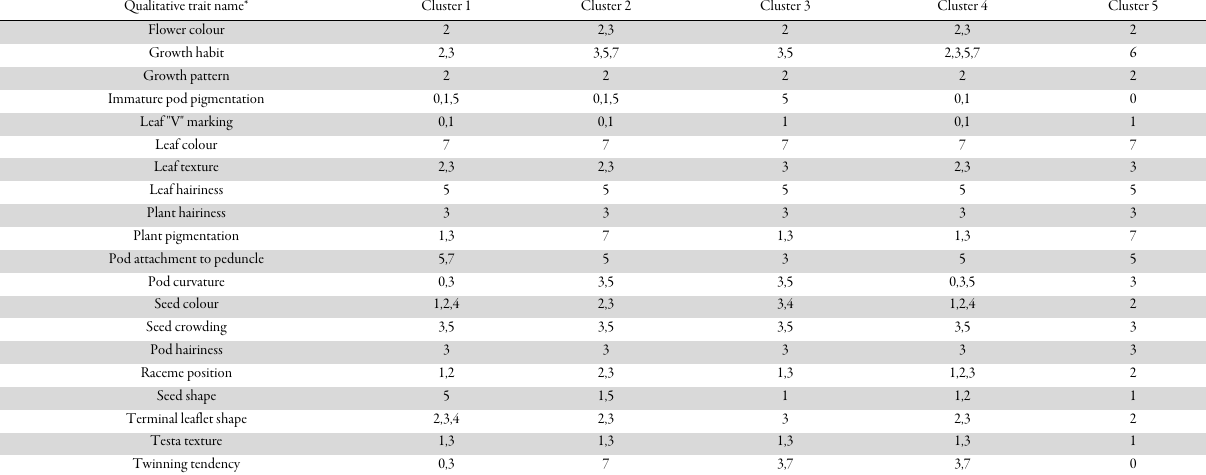
Table 4. Qualitative characteristics of the different clusters of Vigna unguiculata Qualitative trait